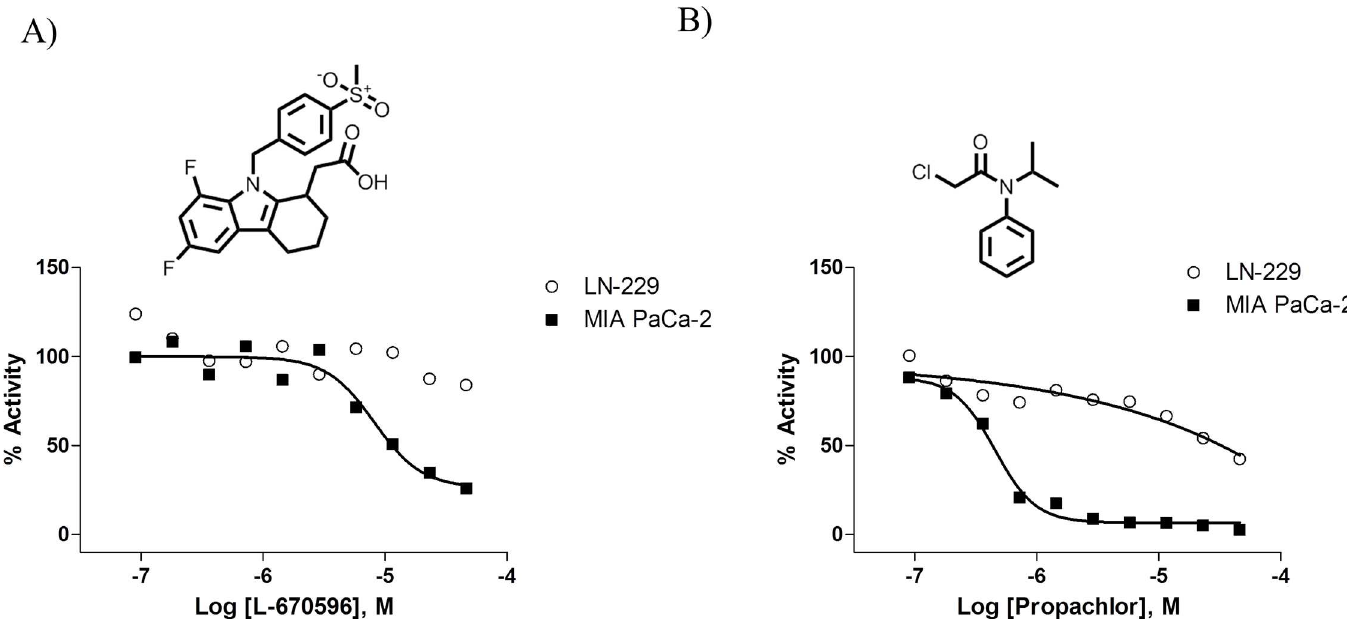
Fig 6. A dual cell-based screening paradigm allows the identification of novel compounds with ALDH1A1 specific inhibitory activity. Structure and representative dose responsecurves of L-670596( A ) and Propachlor( B ) in MIA PaCa-2(ALDH1A1-positive cells) and LN-229 (ALDH1A1-negativecells).